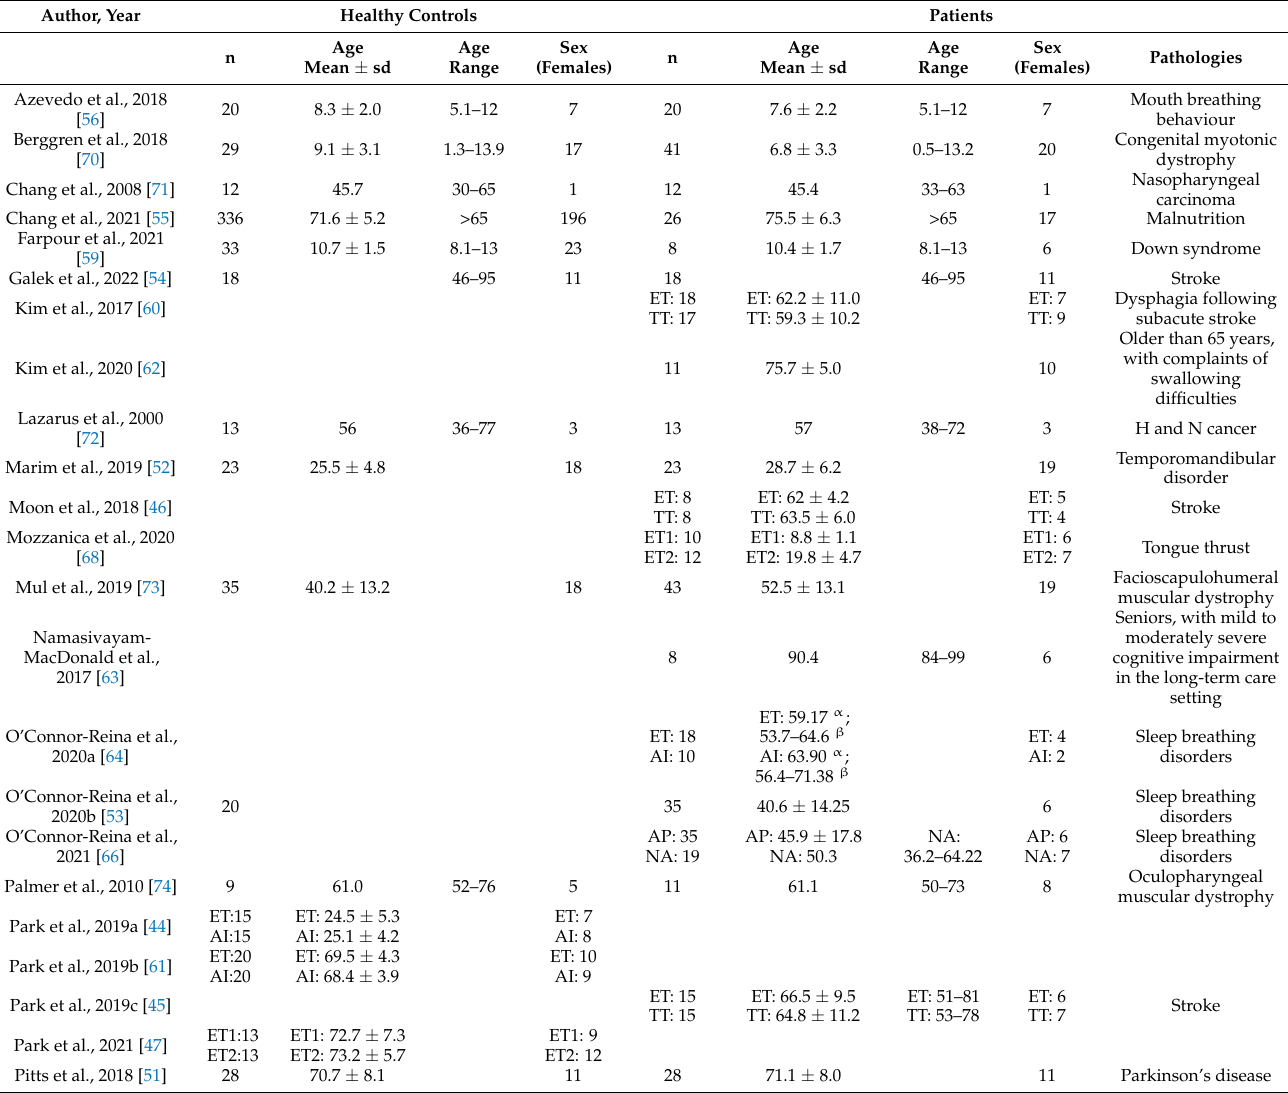
Table 3. Demographic characteristics of the